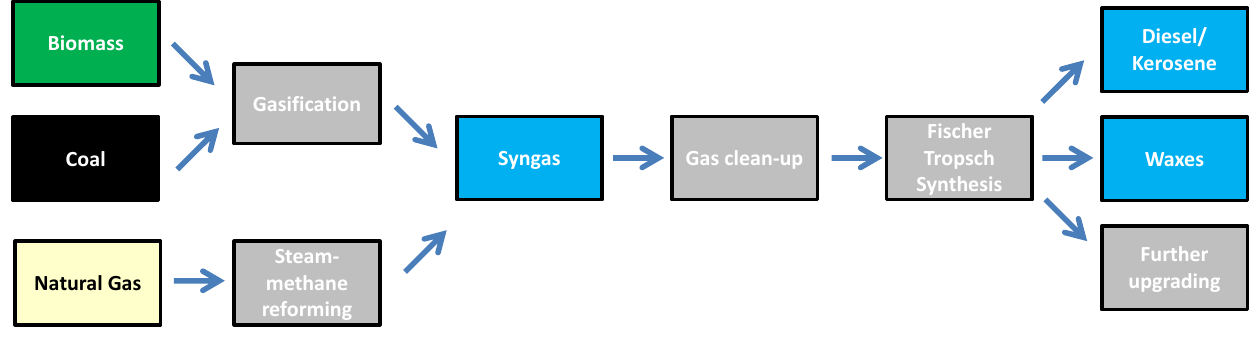
Figure 1. Stages involved in the overall Fischer-Tropsch Synthesis (FTS) process from feedstock to